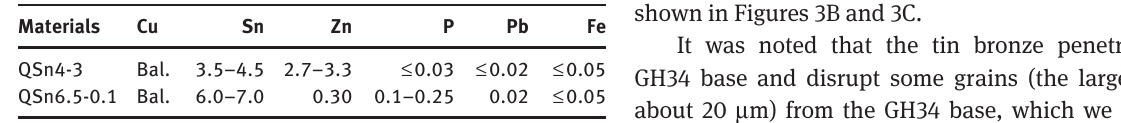
Table 2 Chemical composition of QSn4-3 and QSn6.5-0.1